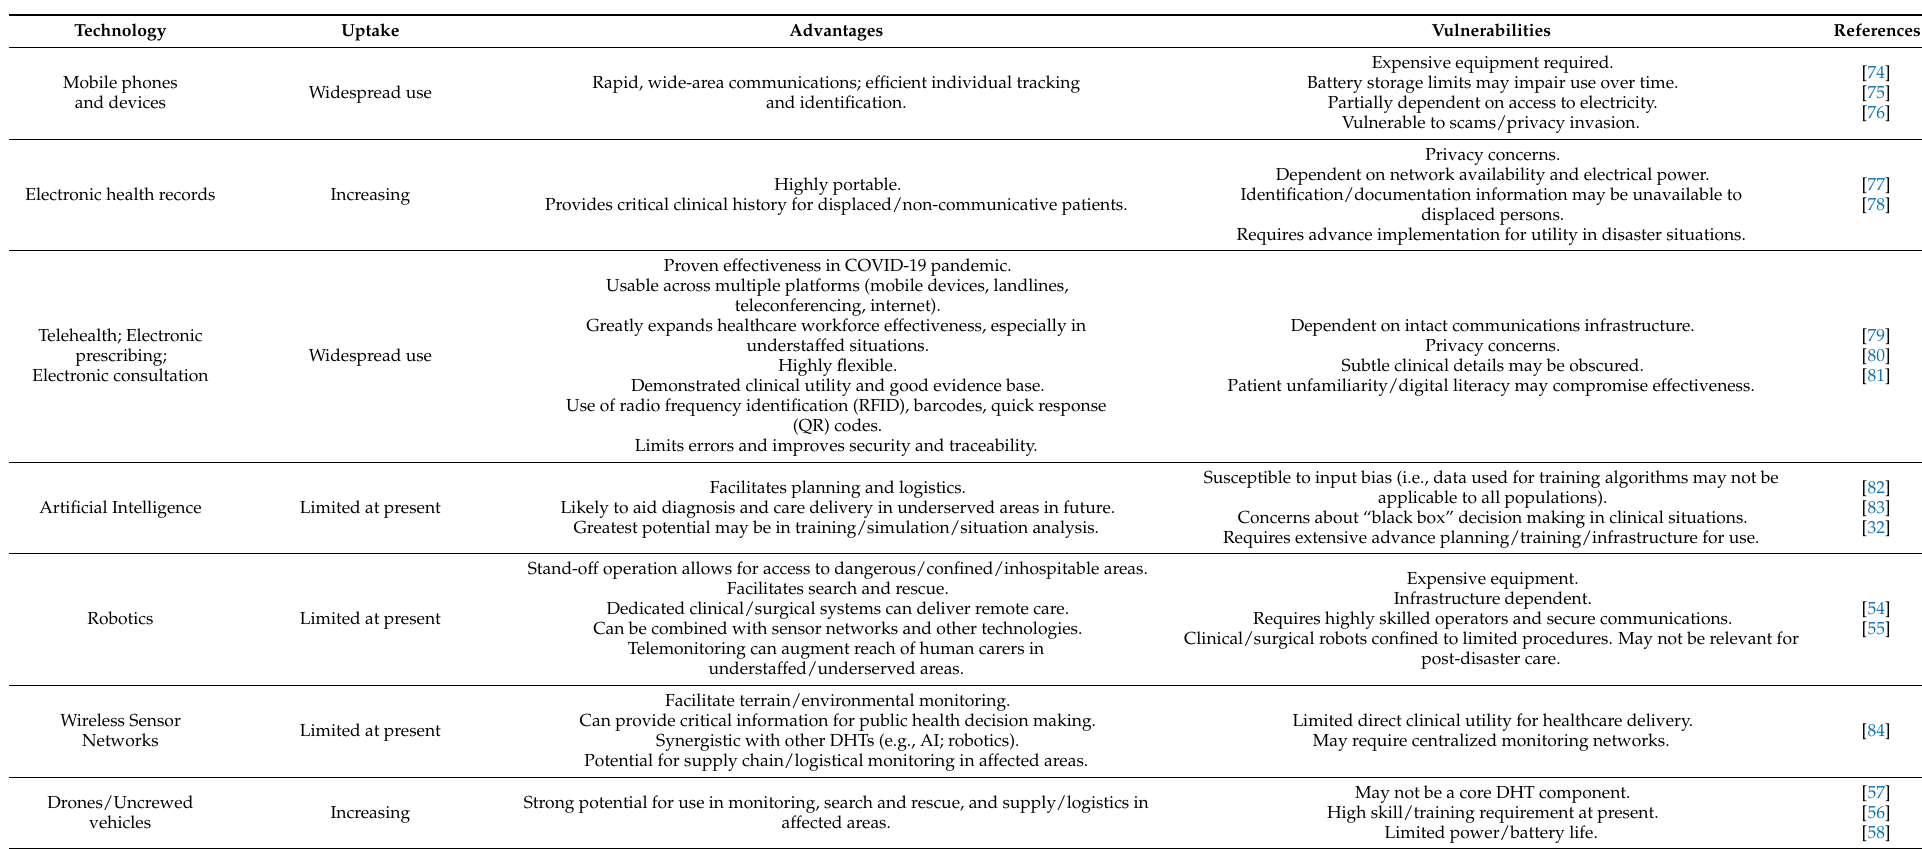
Table 2. Strengths and vulnerabilities of DHTs in the context of natural